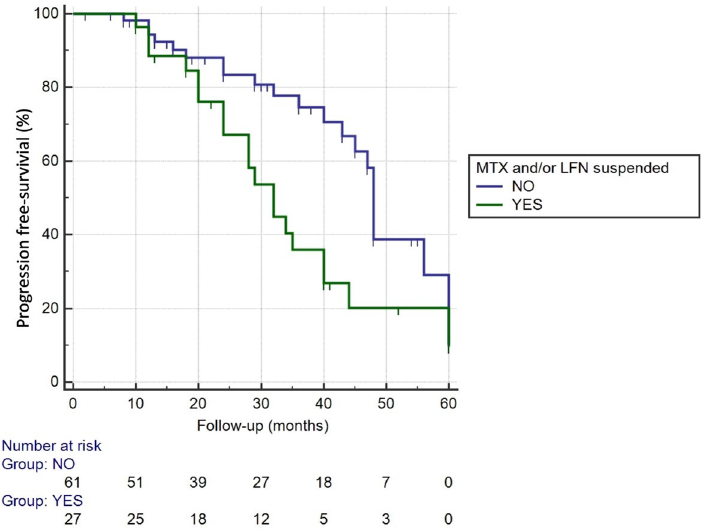
Figure 2. Kaplan–Meier curve for disease progression in RA-ILD during five years period, grouped by discontinuing or not MTX and/or LFN at the moment of ILD diagnosis (Log Rank Test: p = 0.0139).